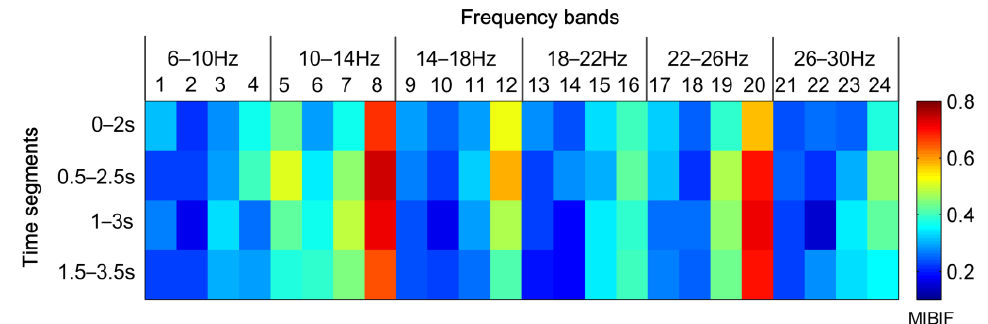
Figure 7. Distribution of MIBIF values in all time-frequency segments for subjects aa. Index 1, 2, . . . , 24 in the frequency bands represent the CSP feature index.